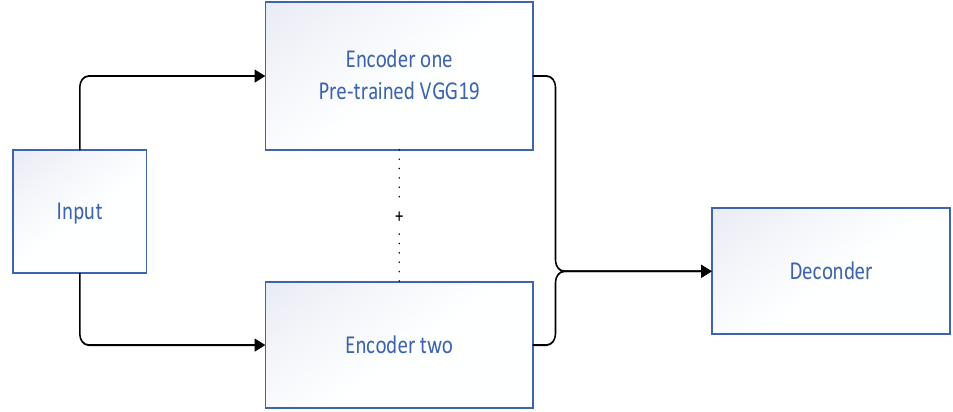
Figure 6. Main framework of Y-Net proposed by Mohammed et al. [23].